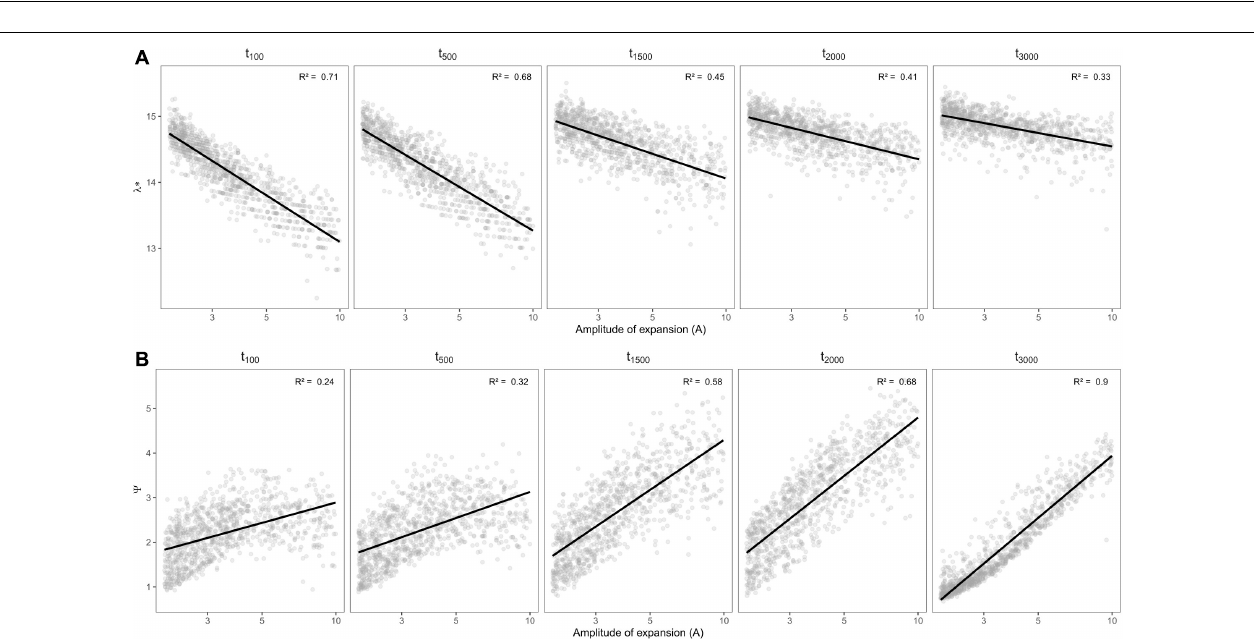
FIGURE 5 | Variation in simulated metrics of phylogenetic diversity (A) Faith’s phylogenetic diversity (PD), (B) mean pairwise distance (MPD), (C) most recent common ancestor (MRCA), and (D) mean nearest taxon distance (MNTD) depending on the amplitude of expansion (A) and the time (in generations) at which it occurred (t c ) . Linear regressions are shown in black with the associated R 2 statistic in the upper-right side of each panel.